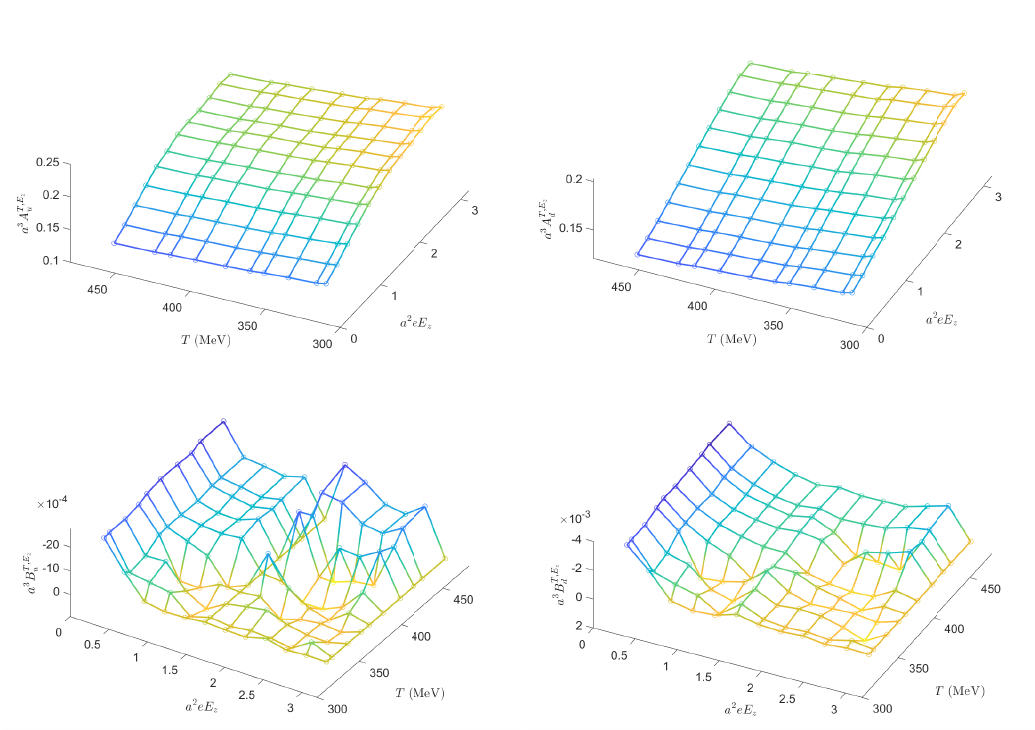
Figure 8 . A q and B q as functions of temperature and E z .